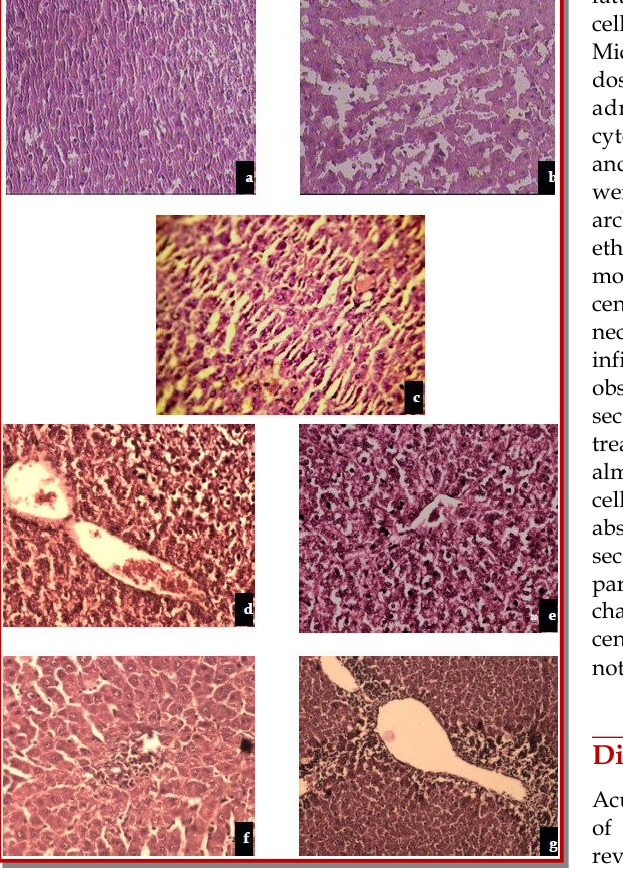
Figure 1: Histopathological study of liver in paracetamol- induced hepatotoxicity in rats (a) Normal control; (b) Paraceta- mol 2,000 mg/kg treated; (c) Silymarin 100 mg/kg treated; (d) Paracetamol 2,000 mg/kg and HEAl 200 mg/ kg; (e) Paraceta- mol 2,000 mg/kg and HEAl 400 mg/ kg (new); (f) Paracetamol 2,000 mg/kg and HEAq 200 mg/ kg(both are of same); (g) Pa- racetamol 2,000 mg/kg and HEAq 400 mg/